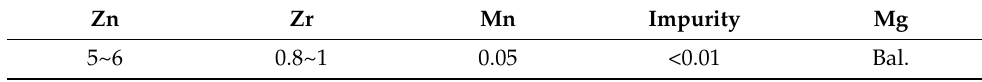
Table 1. Chemical compositions of the experimental alloys (wt.